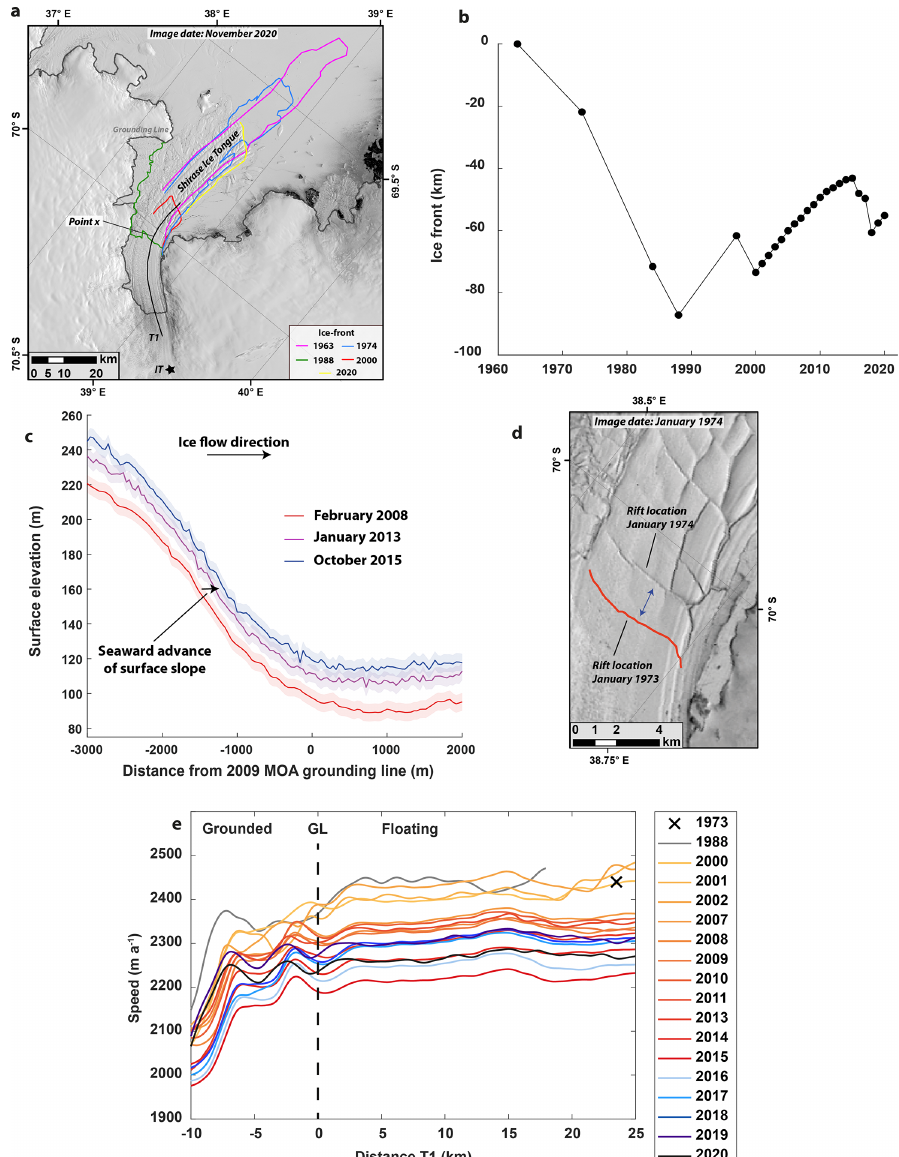
Figure 2. (a) Landsat-8 image from November 2020 showing the Shirase ice tongue. Overlain are selected ice-front positions from 1963, 1974, 1988, 2000 and 2020 along with the transect, T1, used to extract ice speed profiles and point x , which is the location of the 1973/74 ice speed estimate on the floating tongue. Point IT is the location of the ice thickness time series. The grey line is the MODIS 2009 grounding line (Scambos et al., 2007; Haran et al., 2021). (b) Change in ice-front extent relative to 1963. (c) Surface elevation profiles along a small section of T1 as it intersects the grounding line from February 2008, January 2013 and October 2015 showing a seaward migration of the surface slope. (d) Landsat-1 image showing the rift used to estimate ice speed in 1973/74. The red line is the digitized rift from January 1973. (e) Ice speed profiles from transect T1 between 1973 and 2020. The black cross represents the ice speed measurement from 1973/74. Landsat images are courtesy of the U.S. Geological